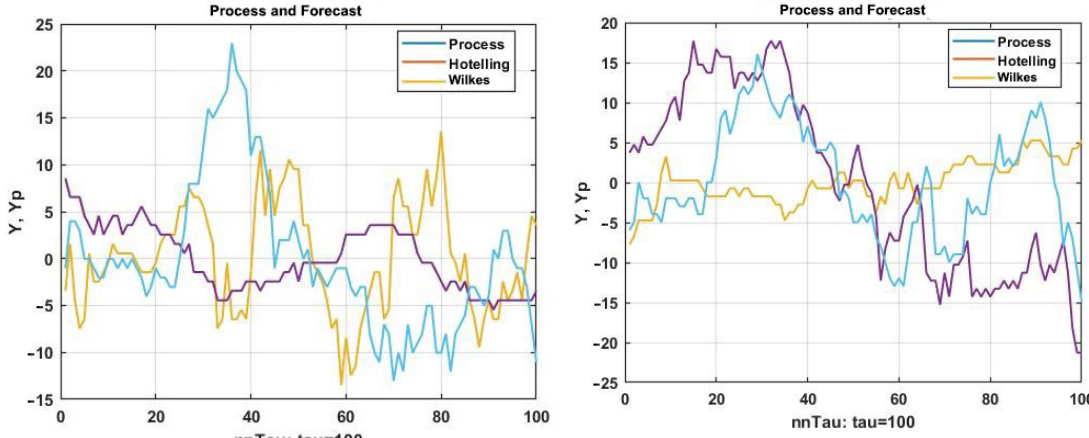
Figure 10. Two examples of implementing a multidimensional precedent forecast using Hotelling and Wilkes metrics.